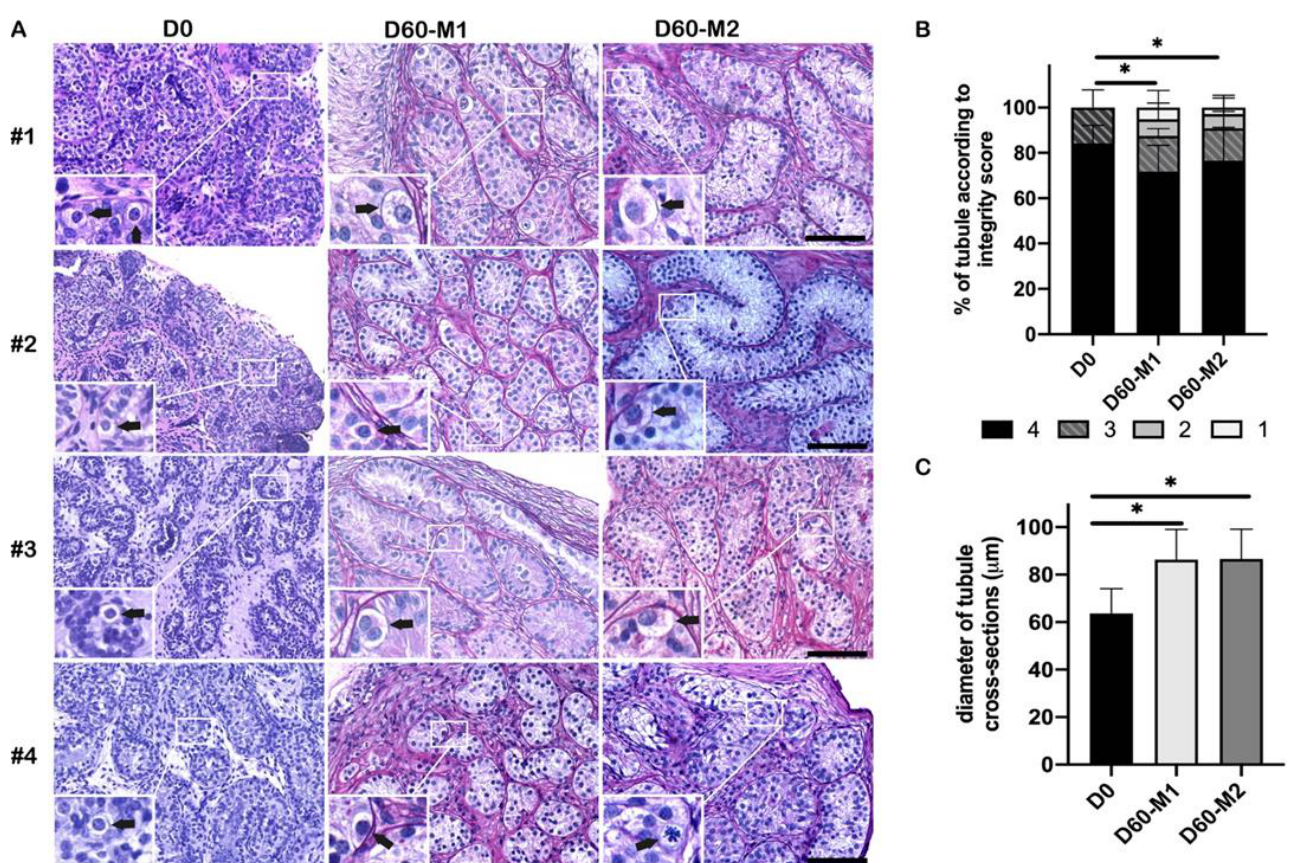
Figure 1. Assessment of ITT organotypic culture. ( A ) The histology of ITT before (D0) and after (D60) organotypic culture (M1 (without RA), M2 (with RA)). Black arrows in the inserts indicated spermatogonia. Scale bar = 100 µ m. ( B ) Percentage of seminiferous tubules according to integrity score. A significant decrease was observed in the percentage of well-preserved tubules (integrity scores 3 and 4) at D60 in both culture media compared to D0 (both p < 0.001). No difference was shown between the two culture media. ( C ) The diameter of tubular cross-sections. Asterisks indicated statistically significant